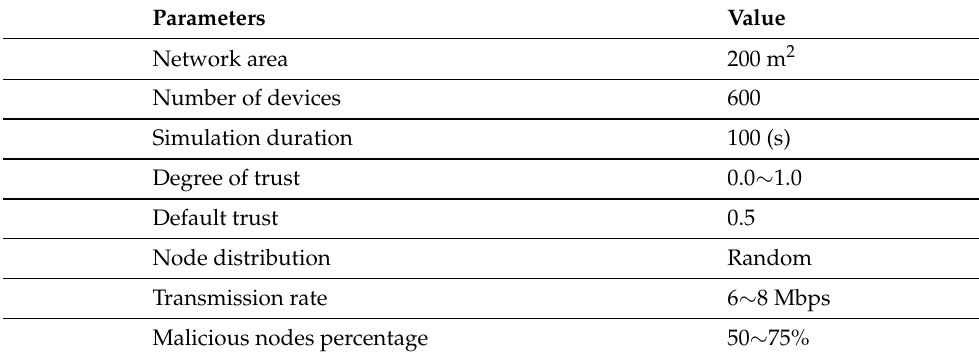
Table 2. Simulation Environment Implementation Setup.